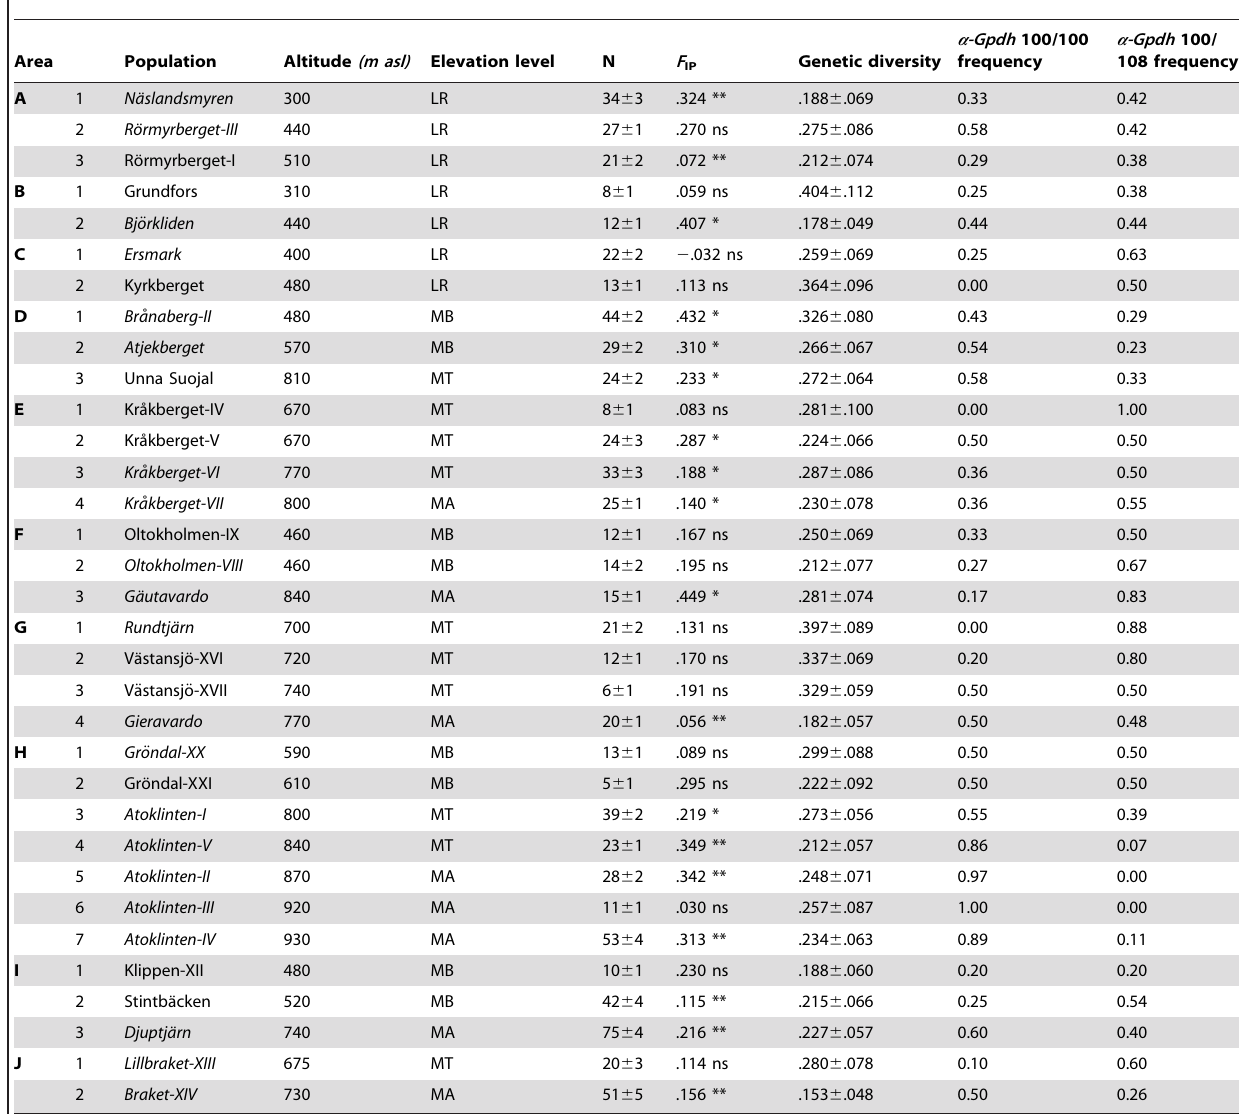
Table 1. Population variables of the sampled Agabus bipustulatus populations in northern